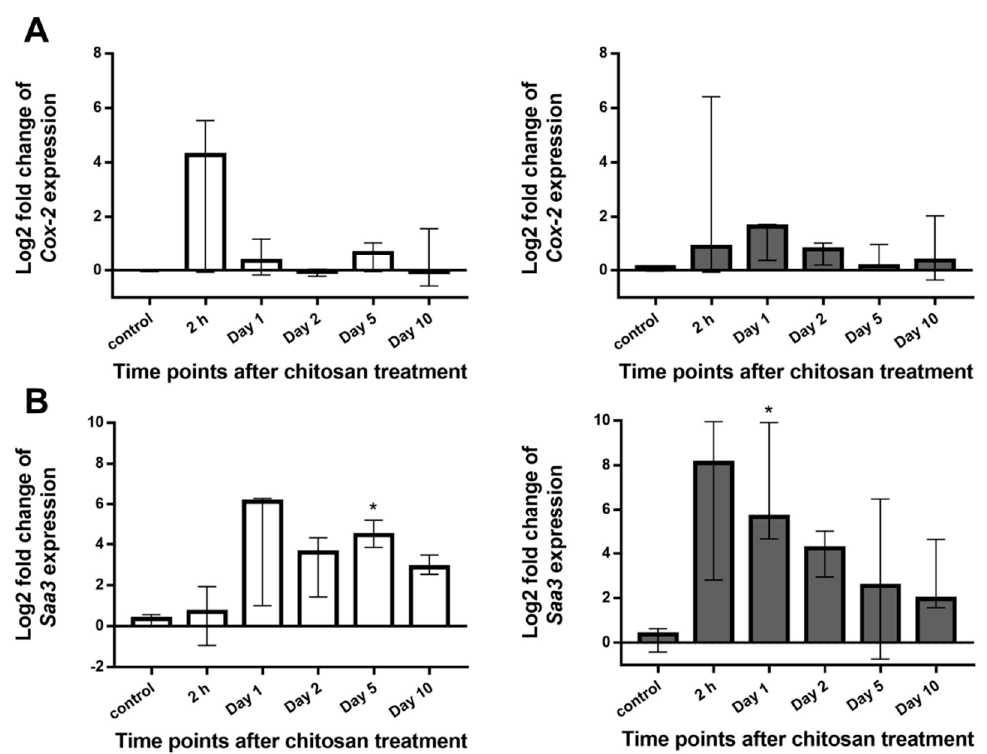
Figure 11. ( A ) Quantification of cyclooxygenase 2 ( Cox-2 ) mRNA expression in the urinary bladder of young (white columns) and old (grey columns) mice. ( B ) Quantification of serum amyloid A3 ( Saa3 ) mRNA expression in the urinary bladder of young (white columns) and old (grey columns) mice. In the period after chitosan treatment, median Saa3 expression levels were higher in comparison to the control mice of both age groups. Three animals per each time point. Median ± interquartile range (IQR). * p < 0.05.